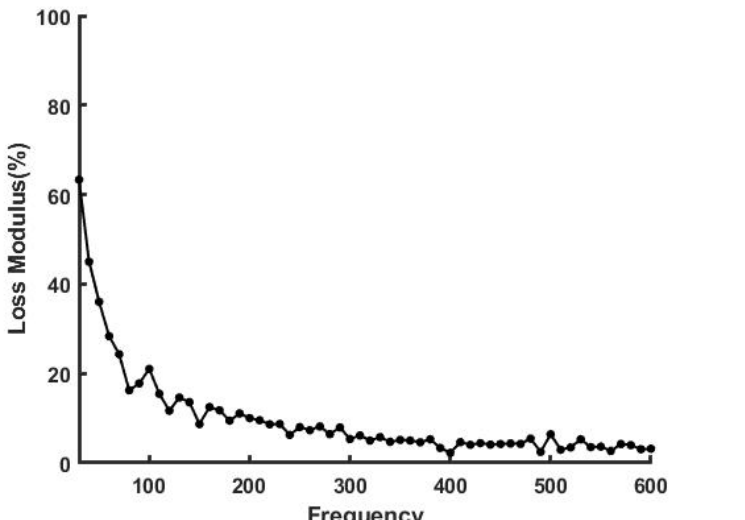
Figure 6. Loss modulus as a % of the elastic modulus for human skin over the biceps muscle in vivo. Note the loss modulus is about 65% at 30 Hz and drops to about 20% at the resonant frequency of collagen. The resonant frequency of cells is between 50 to 70 Hz (Table 1).